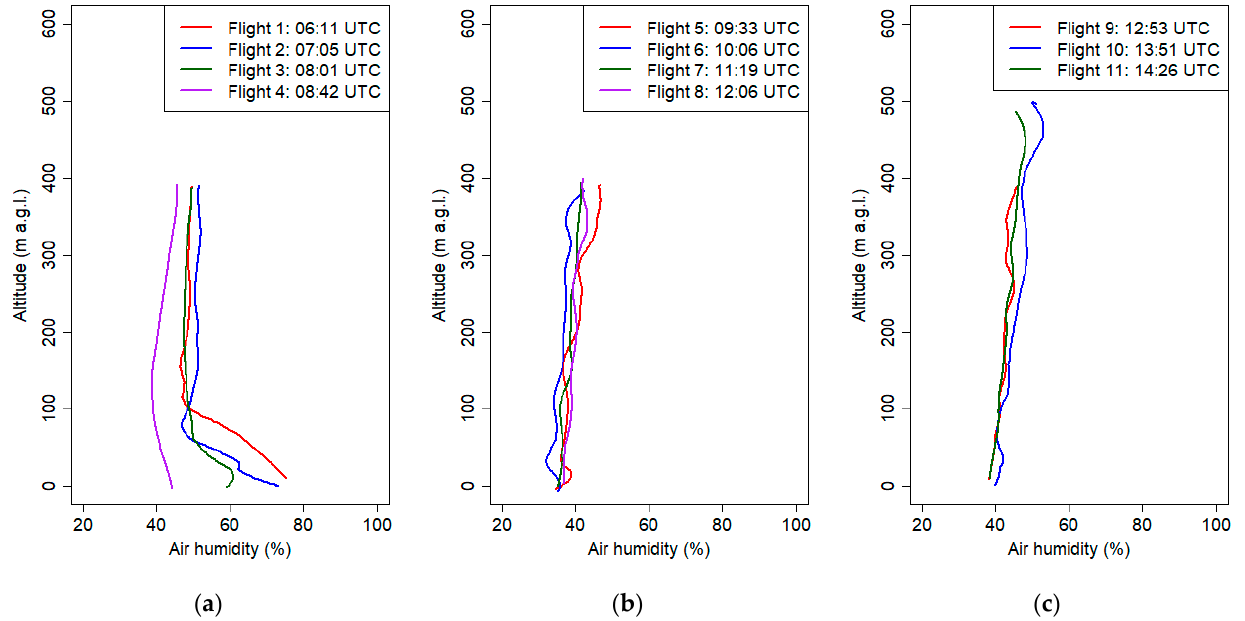
Figure 16. Vertical profiles of relative humidity on March the 7th, 2019 from 6:00 UTC to 15:00 UTC.